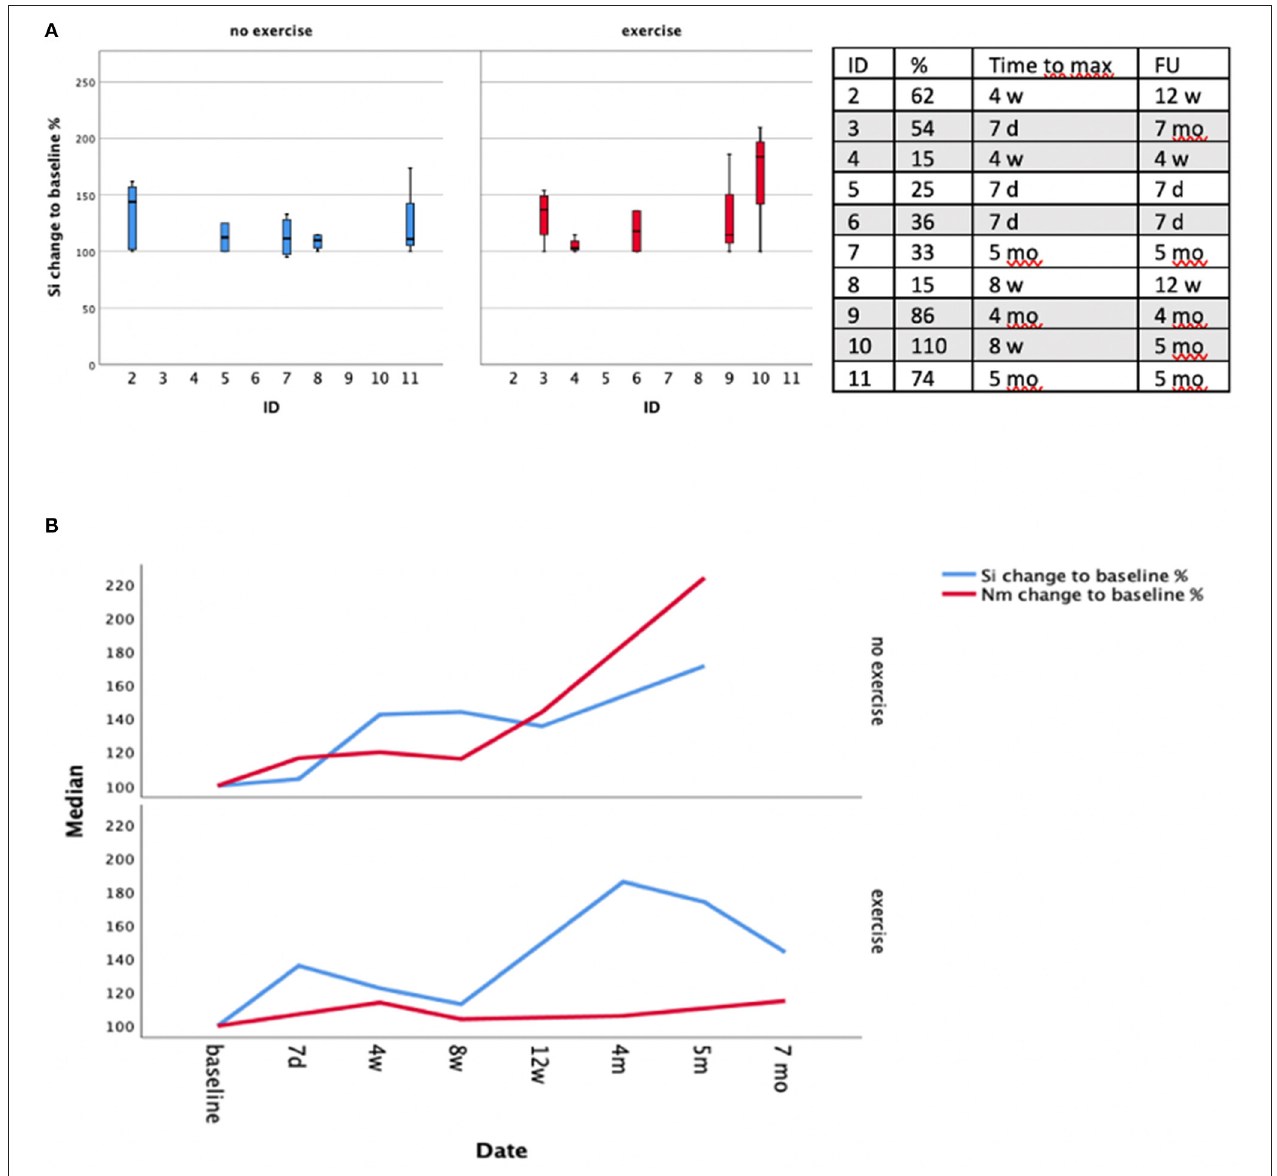
FIGURE 2 | (A) Left: Longitudinal change in T2 signal intensity in the MBB with reference to baseline per patient. Right: Time interval until maximum T2 Si- value was reached per patient. Patients having received exercise are labeled gray (B) Median change in strength level (Nm, %) and T2 signal intensity (Si, %) compared to baseline levels across the groups (exercise vs. no